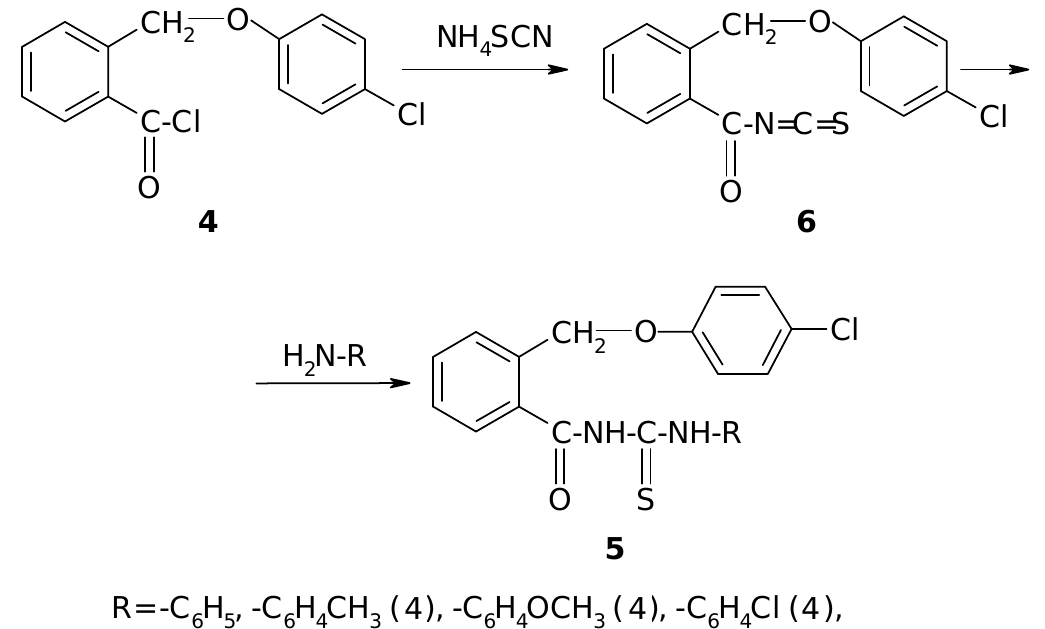
Figure 3. The synthesis of the new thioureides 5a-h.